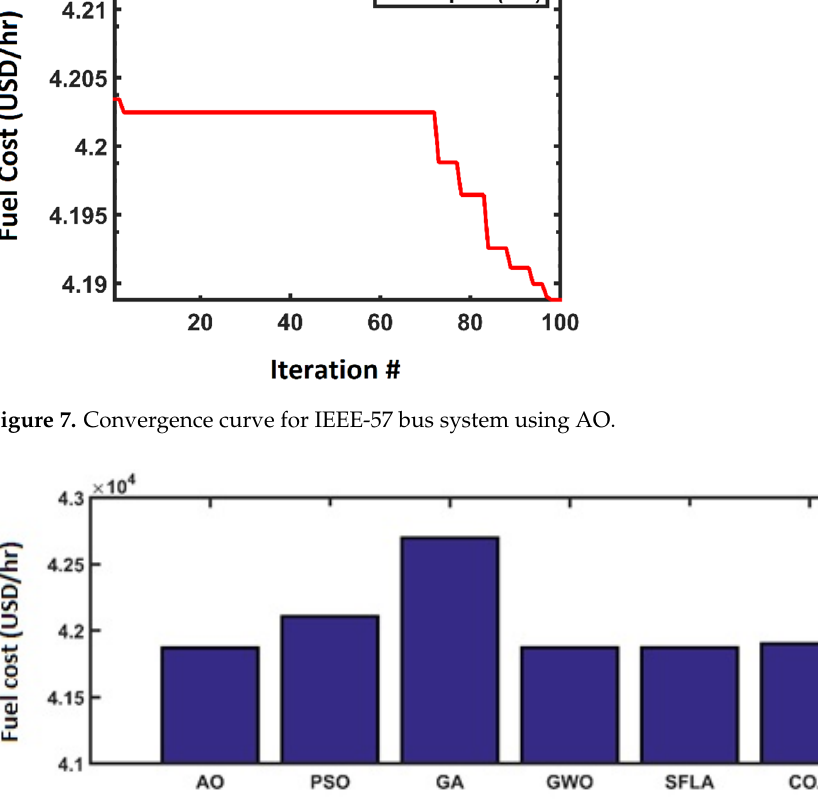
Figure 8. Fuel cost comparison for IEEE-57 bus system. Table 3. Result comparison for OPF IEEE ‐ 57 bus system.